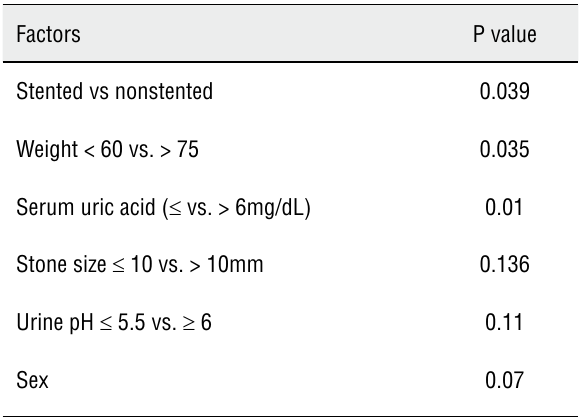
Table 2 - Statistical significance of factors affecting dissolution.